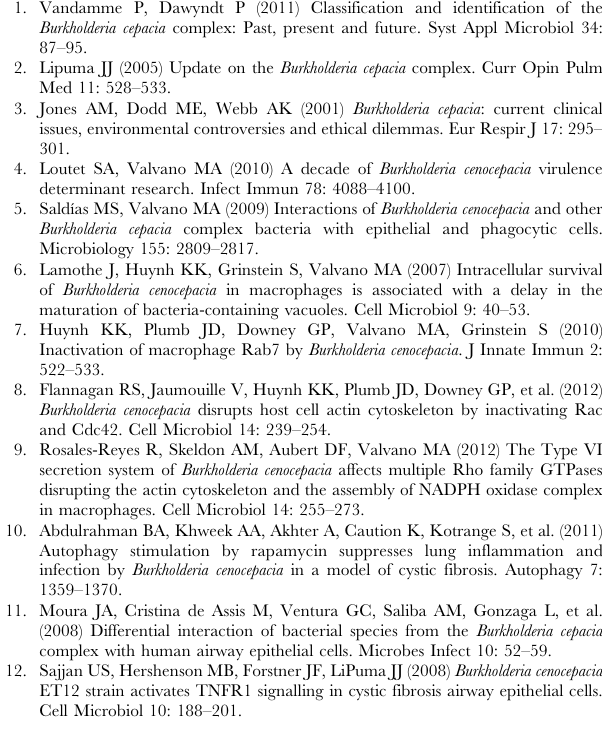
ZmpB does not impair the ability of intracellular